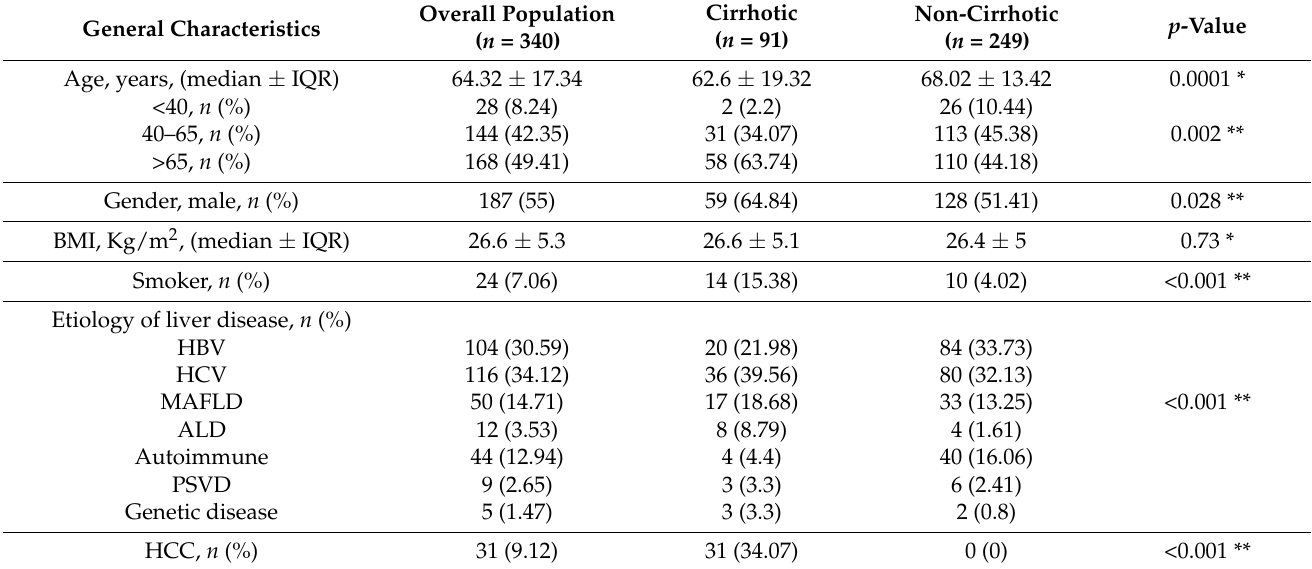
Table 1. General characteristics of population and comparison between cirrhotic and non-cirrhotic